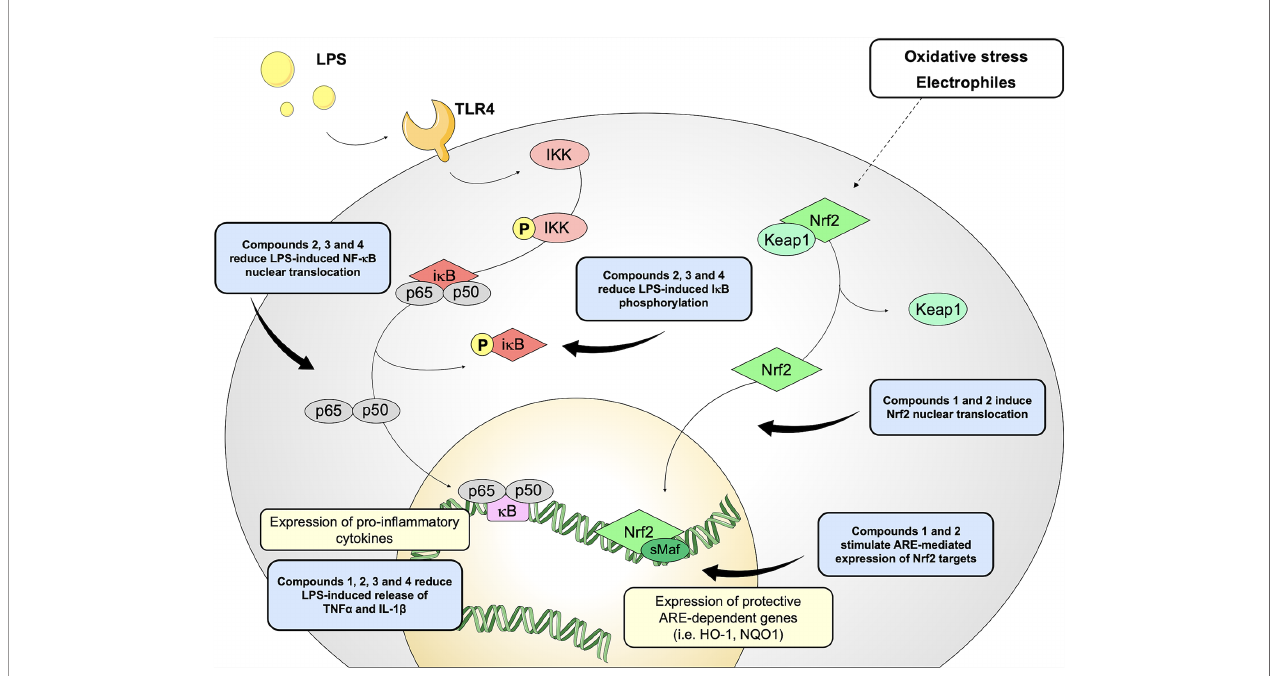
FIGURE 8 | Schematic representation of the effects induced by compounds 1 – 4 on Nrf2 and NF- k B